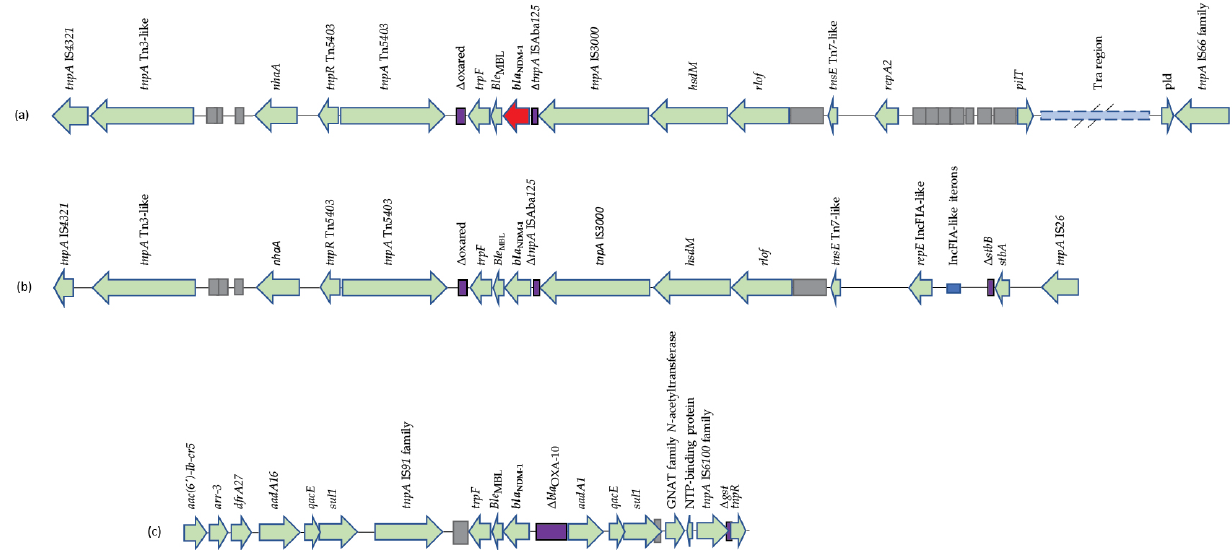
Figure 2. Presentation of different bla NDM-1 genetic context. ( a ) 9703 and A1630 identical to plasmid pB-3002cz (Accession Number KJ958926); ( b ) 9793, A155, A1160, A3025, A3026, A3039 and A3040 identical to plasmid pS-3002cz (Accession Number KJ958927); ( c ) A2614 identical to plasmid pEc19397-131 (Accession Number MG878866).